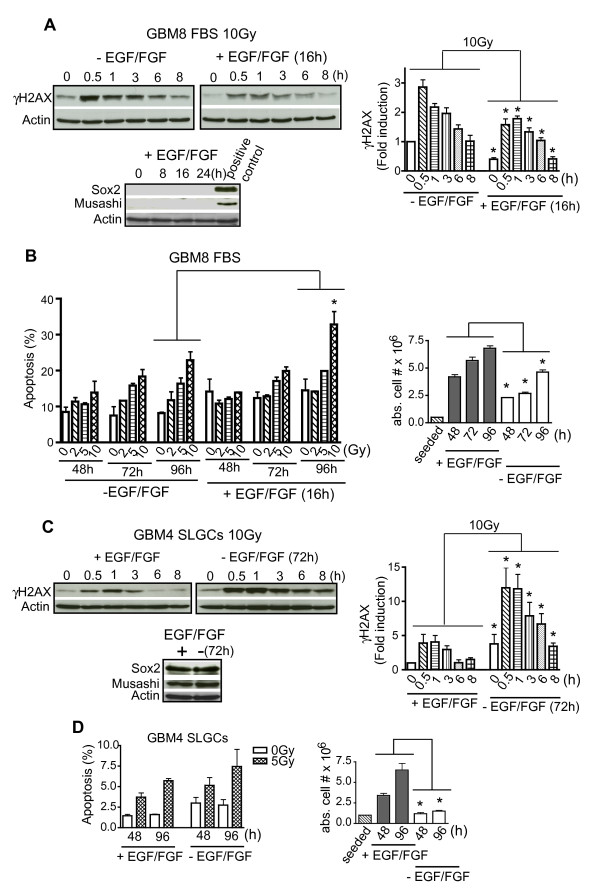
EGF/FGF-dependence of γIR-induced H2AX-phosphorylation and of apoptosis. A. Differentiated GBM8 FBS cultures pretreated or not for 16 h with EGF plus FGF-2 were irradiated with 10 Gy and analyzed for γH2AX levels by Western blotting (upper left); quantification using Image Quant TL (upper right). Expression levels of the stem-cell and progenitor markers Sox2 and musashi were determined to assess the differentiation status of the cells (lower). B. GBM8 FBS cultures treated as in A were analyzed for apoptosis (left) and proliferation (right). C. GBM4 SLGCs either treated or not with EGF plus FGF-2 for 72 h were irradiated with 10 Gy and analyzed for γH2AX-levels by Western blotting (upper left); quantification (upper right). Expression levels of the stem- and progenitor markers Sox2 and musashi were determined to assess the differentiation status of the cells (lower). D. GBM4 SLGCs treated as in C were analyzed for apoptosis (left) and proliferation (right). Representative Western blots are presented. In the other graphs, the mean ± S.D. of three experiments is shown; asterisk, = p < .05.